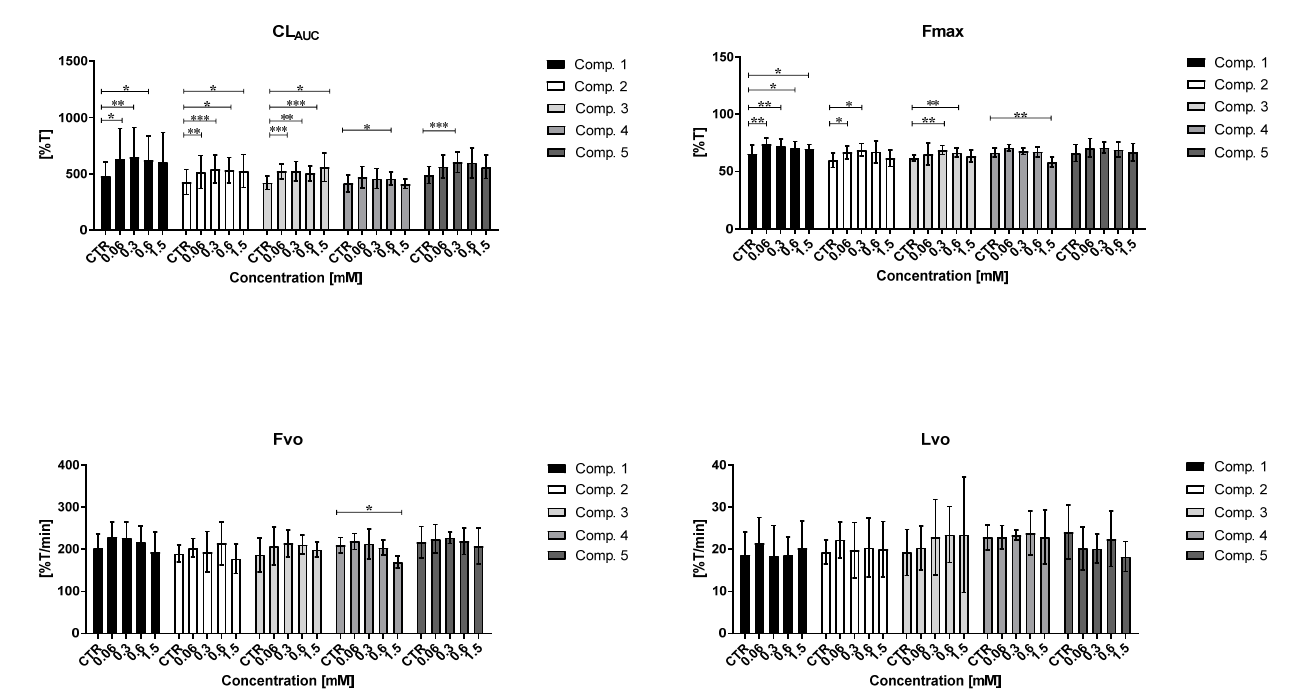
Figure 8. Influence of chosen biguanides 1 – 5 on overall potential of clot formation and fibrinolysis (CL AUC ), and selected parameters of clot formation and fibrinolysis process: maximum clotting (Fmax); initial plasma clotting velocity (Fvo); initial clot fibrinolysis velocity (Lvo) (data are presented as means, n = 5–7). The asterisk denotes a statistically significant difference between the samples treated with compounds and respective controls; * p < 0.05, ** p < 0.01, *** p < 0.001. In our previous study, metformin did not affect the overall potential of clot formation and fibrinolysis (CL AUC ) over the entire concentration range and dimethyl biguanide did not influence the kinetic parameters of the clot formation process and fibrinolysis (Fmax, Fvo, Lvo constants) [37].